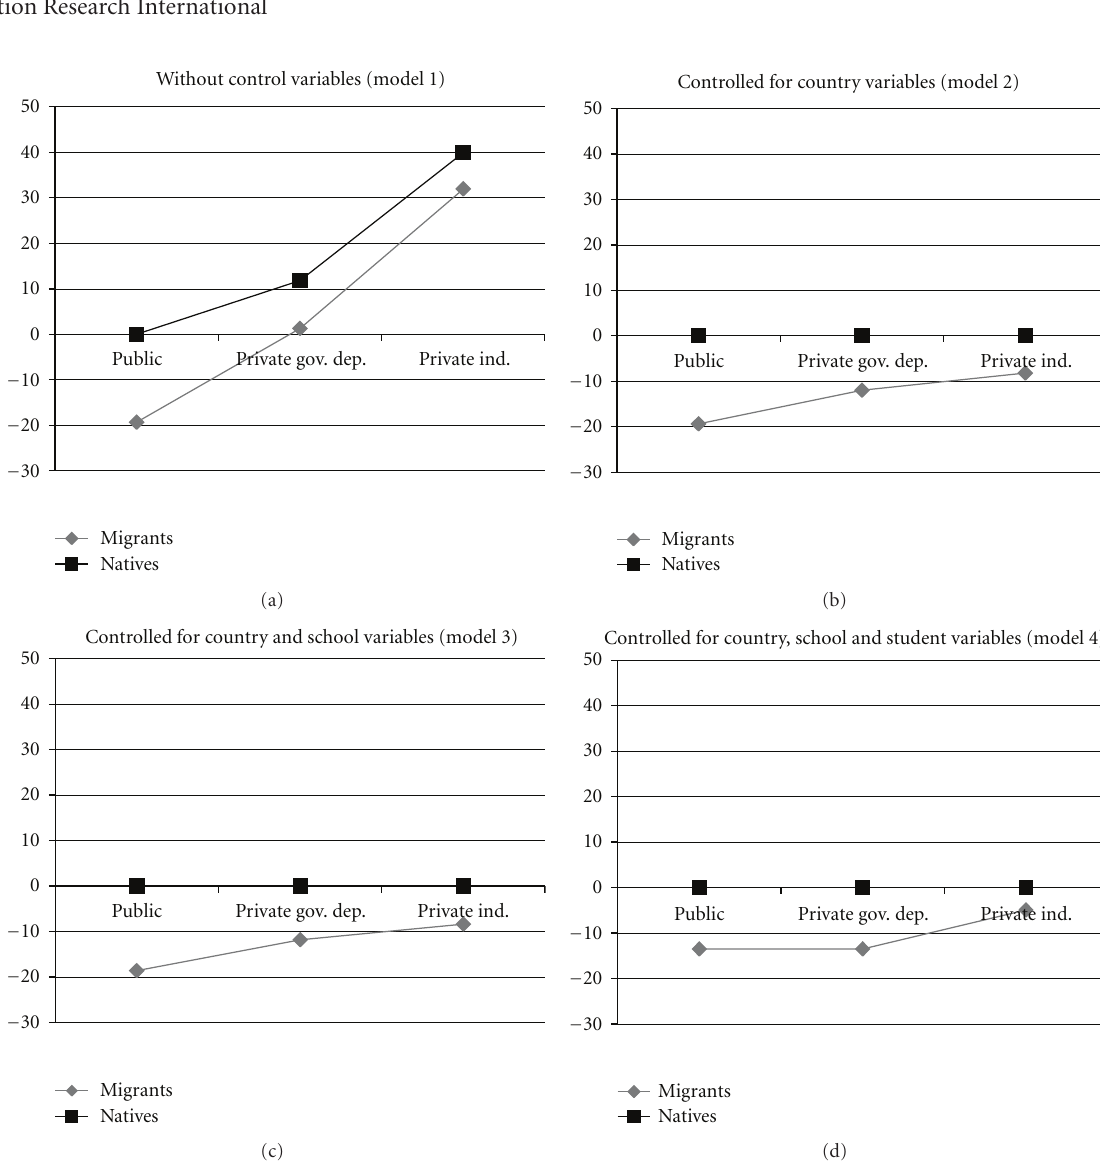
Figure 1: E ff ects of migration status and school type on mathematics